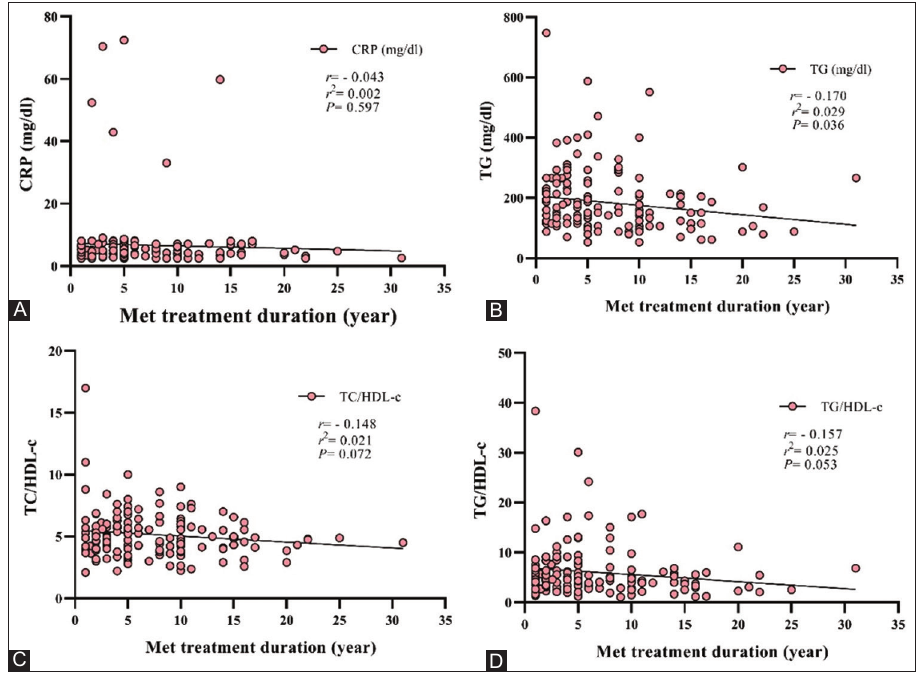
FIGURE 5. Correlation of metformin treatment duration with (A) CRP levels, (B) TG levels, (C) TC/HDL‑c ratio, and TG/HDL‑c ratio (D) of Iraqi patients with